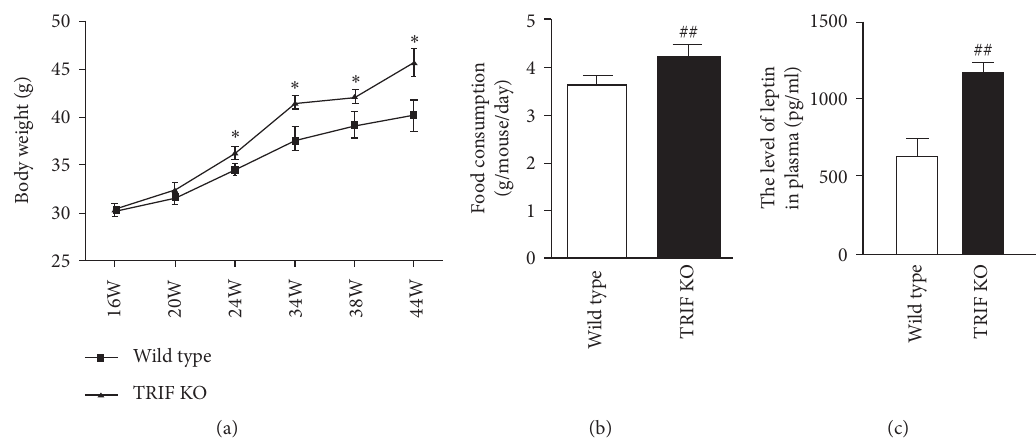
Figure 1: Effects of TRIF deficiency on bodyweight, food consumption, and plasma leptin levels. (a) Animals were weighed weekly from 16 weeks of age through 44 weeks. (b) Food consumption was recorded weekly from 36 weeks through 40 weeks. (c) Plasma samples were harvested at the age of 48 weeks, and plasma leptin was determined by leptin ELISA kit ( ∗ P < 0 . 05, ## P < 0 . 001) ( n �